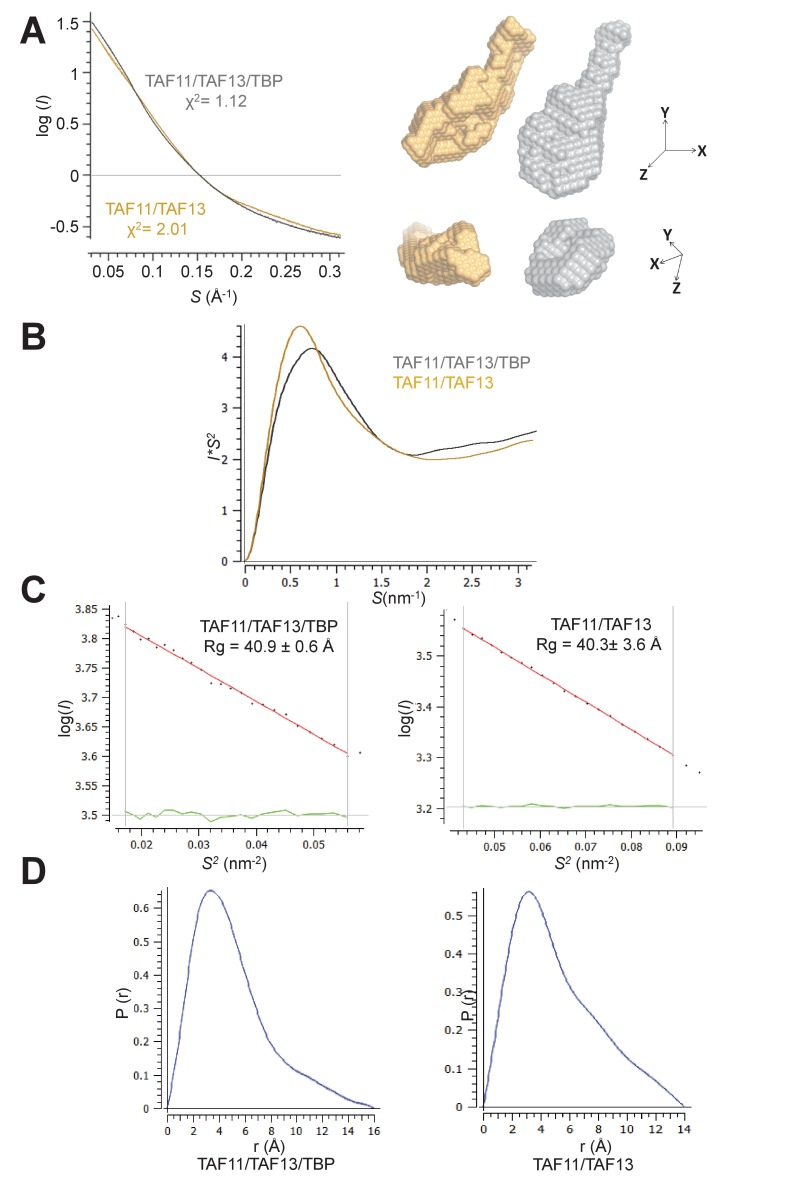
Small angle X-ray scattering (SAXS).(A) Small-angle X-ray scattering (SAXS) data of TAF11/TAF13/TBP and TAF11/TAF13. Fit of experimental scattering (dots) and scattering calculated from ab initio models (solid lines) is provided in a log plot (left). SAXS envelopes of TAF11/TAF13 (yellow), TAF11/TAF13/TBP (grey) and an overlay are shown (right). (B) Kratky plots for TAF11/TAF13/TBP (light gray) and TAF11/TAF13 (light orange). (C) Guinier plots for TAF11/TAF13/TBP (left) and TAF11/TAF13 (right) are shown; Rg values are indicated. Residuals of the linear fit are represented as green lines. (D) Distance distribution analysis for TAF11/TAF13/TBP (left) and TAF11/TAF13 (right). SAXS statistics are provided in Table 3.